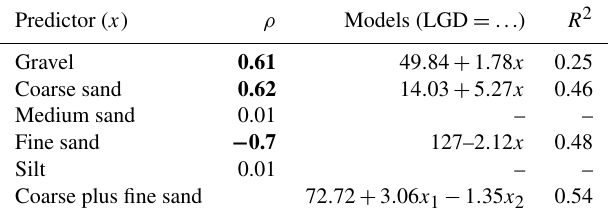
Table 3. Correlation coefficients ( ρ ), linear models describing the correlation between LGD and predictors and the coefficient of de- termination ( R 2 ). ρ values given in boldface indicate significant correlation ( p value > 0 . 05); normal typeface values indicate in- significant correlations ( p value < 0 .